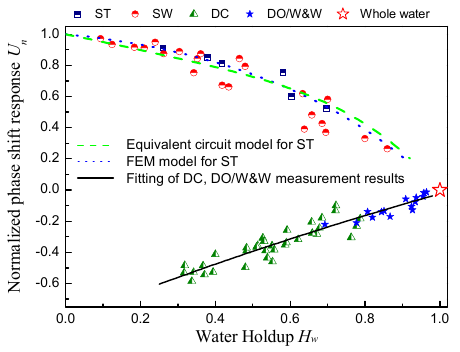
Figure 15. Phase shift response characteristics of the CCS in horizontal oil–water two-phase flow. The red star symbol denotes the sensor response when the pipe is filled with water.